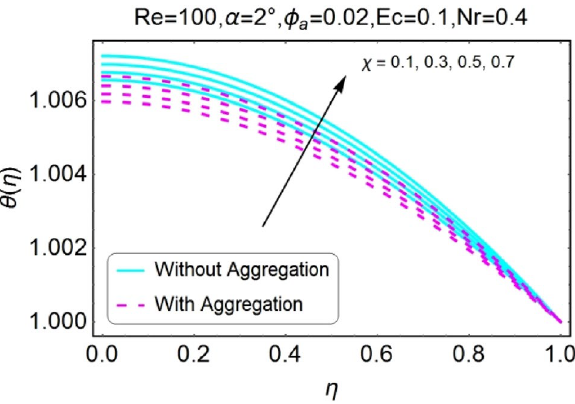
Figure 18. χ varying θ for stretching walls (divergent